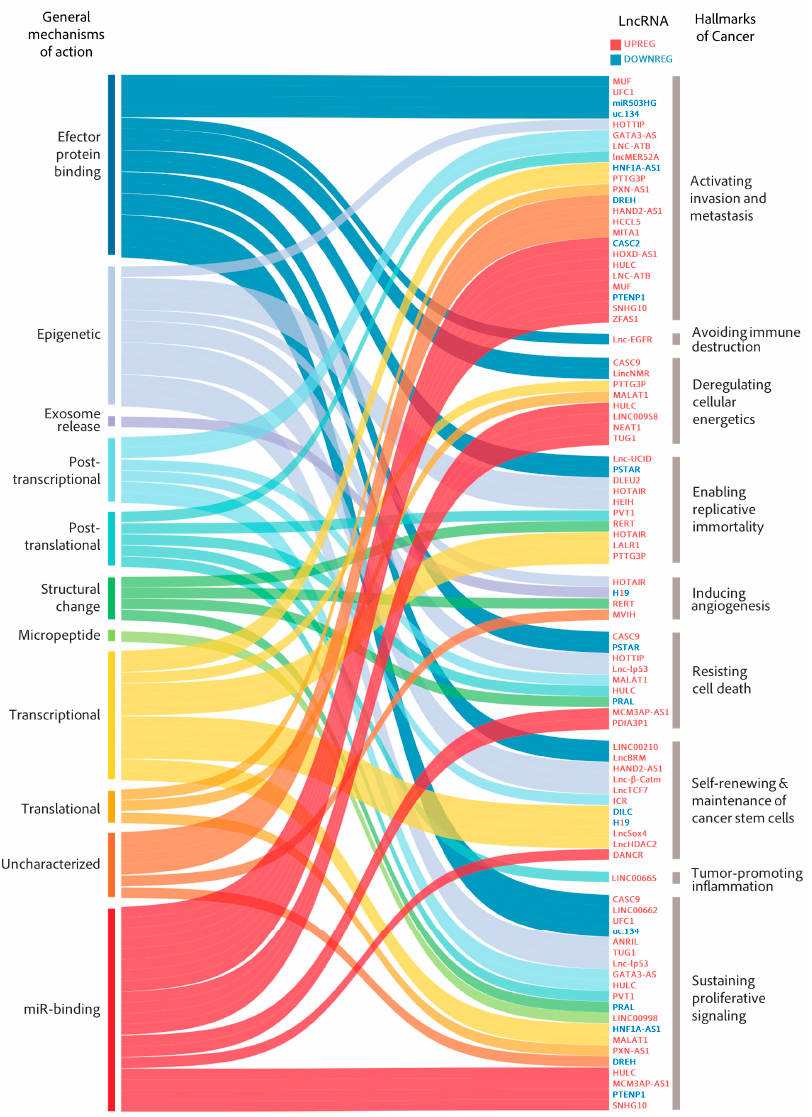
Figure 2. Sankey diagram linking mechanisms of action and hallmarks of cancer of HCC-relevant lncRNAs. LncRNAs selected according to scientific significance, preclinical validation and/or associ- ation with relevant clinical parameters have been classified according to their mechanism of action (left) and the cancer hallmark they modulate (right). Note that some lncRNAs have been assigned to several mechanisms of action and/or different cancer hallmarks. LncRNAs downregulated in HCC are shown in blue while those upregulated are in red. The full list of candidates in shown in Table